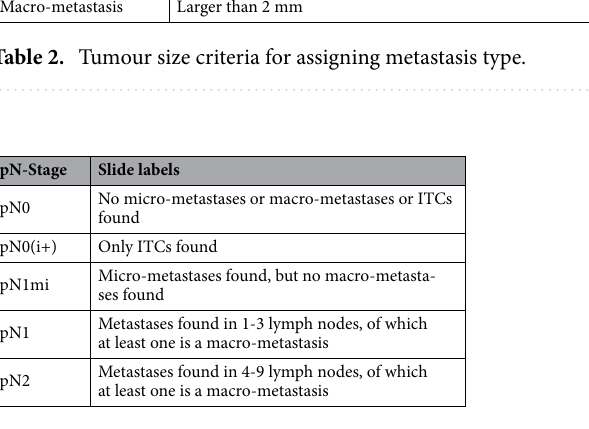
Table 3. Pathologic lymph node classification (pN-stage) in CAMELYON17 Challenge.